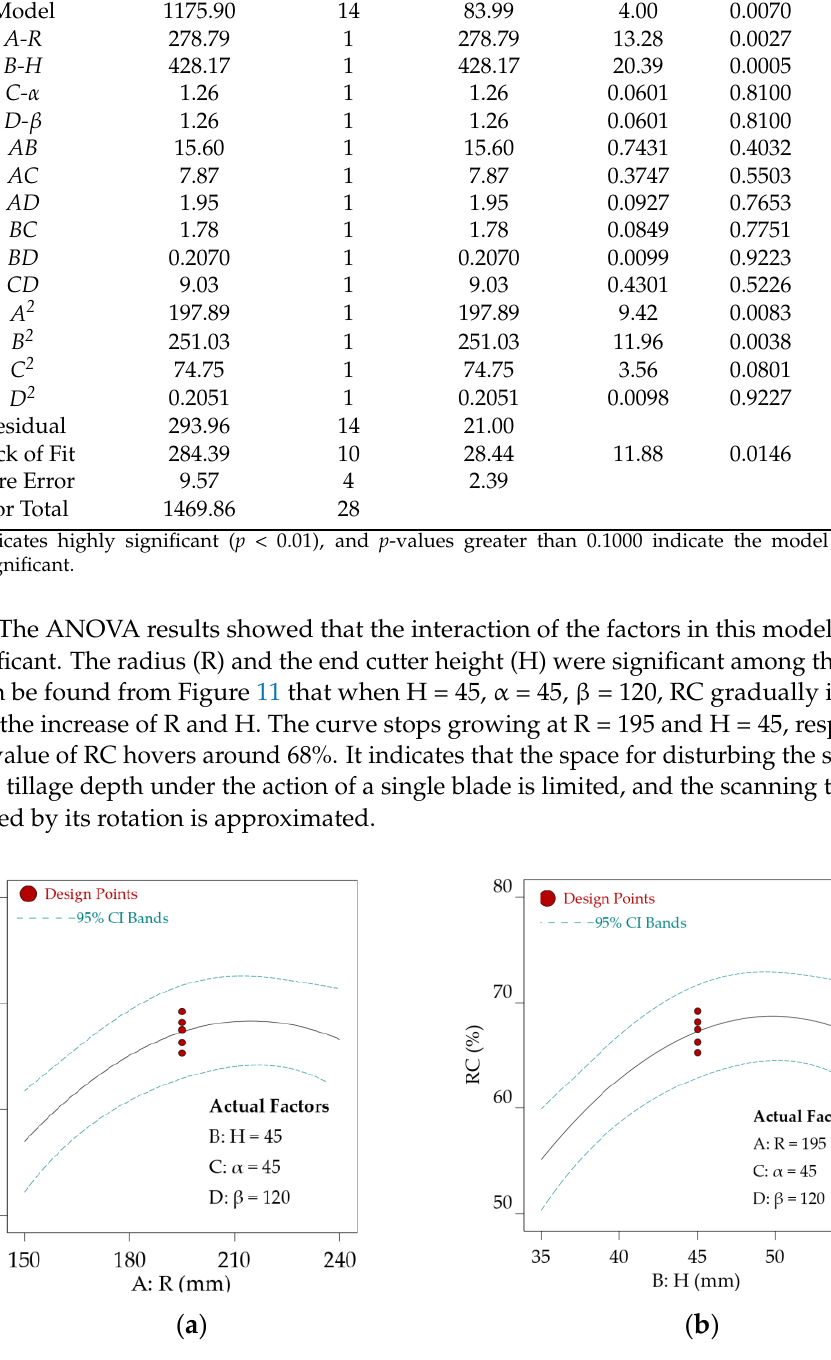
Figure 11. Rate of crushed soil value at different